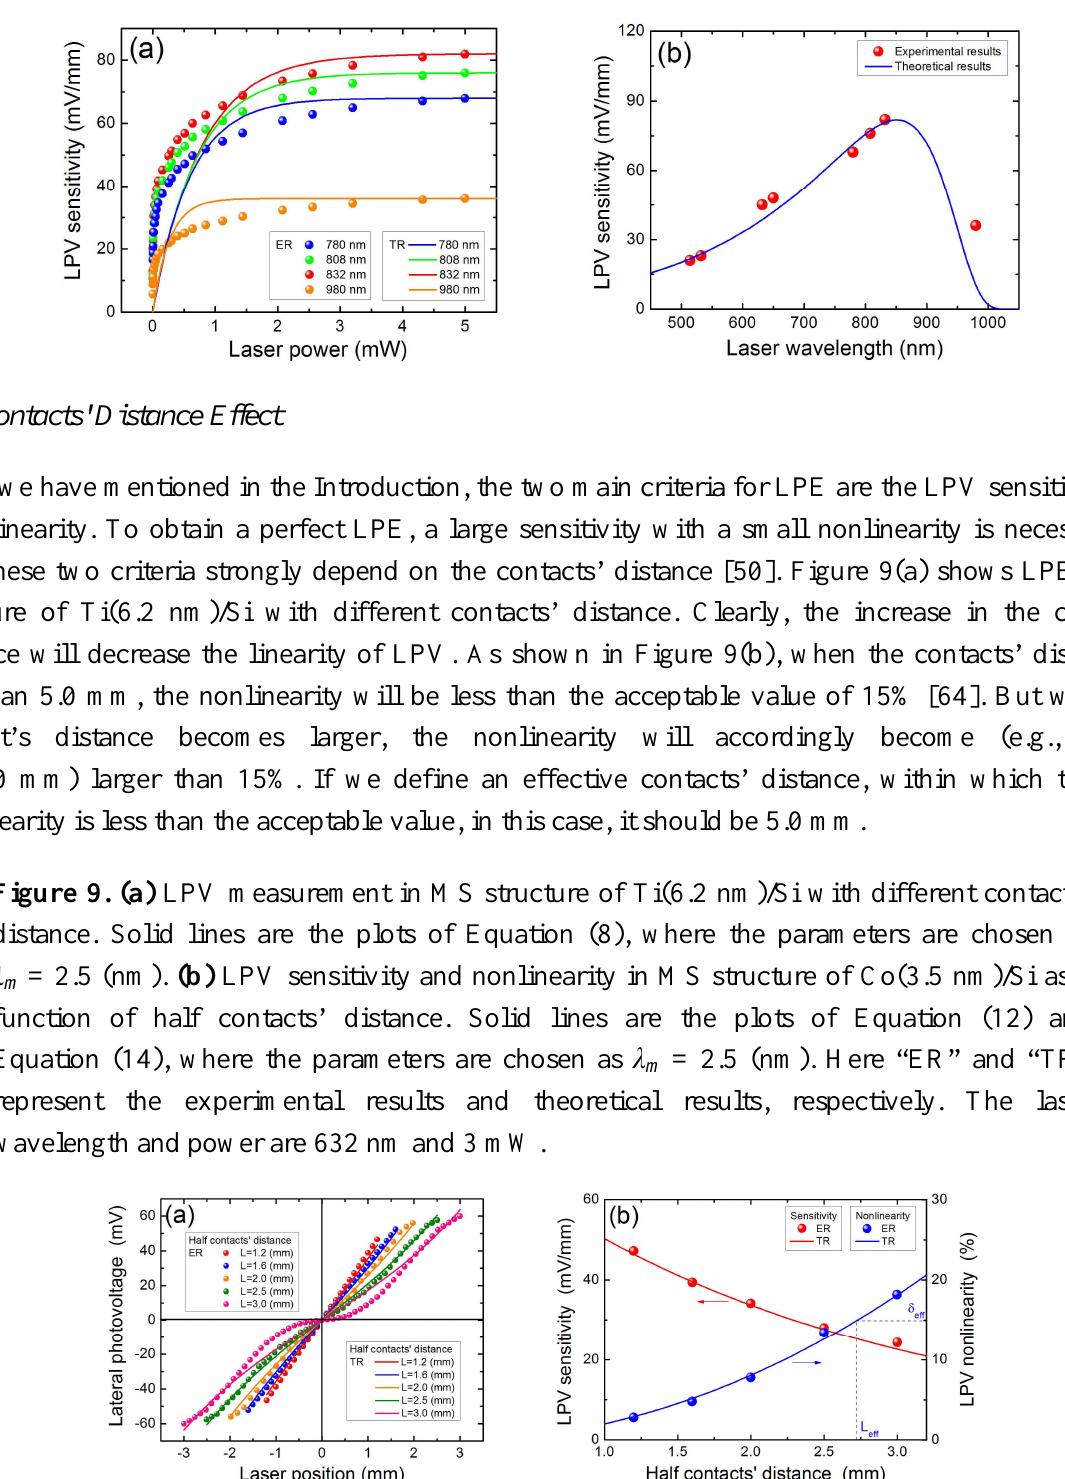
Figure 8. (a) LPV measurement in MS structure of Co(3.5 nm)/Si as a function of laser power with different light wavelength, where “ER” and “TR” represent the experimental results and theoretical results, respectively. (b) LPV measurement in MS structure of Co(3.5 nm)/Si as a function of light wavelength in Co(3.5 nm)/Si structure, where the light power is 5 mW. Here the contacts’ distance is 3.2 mm. Solid lines are the plots of Equation (23) and Equation (24), where the parameters are chosen as E d = 2.9 (nm), α = 0.5, β = 2 and P = 0.5. 0